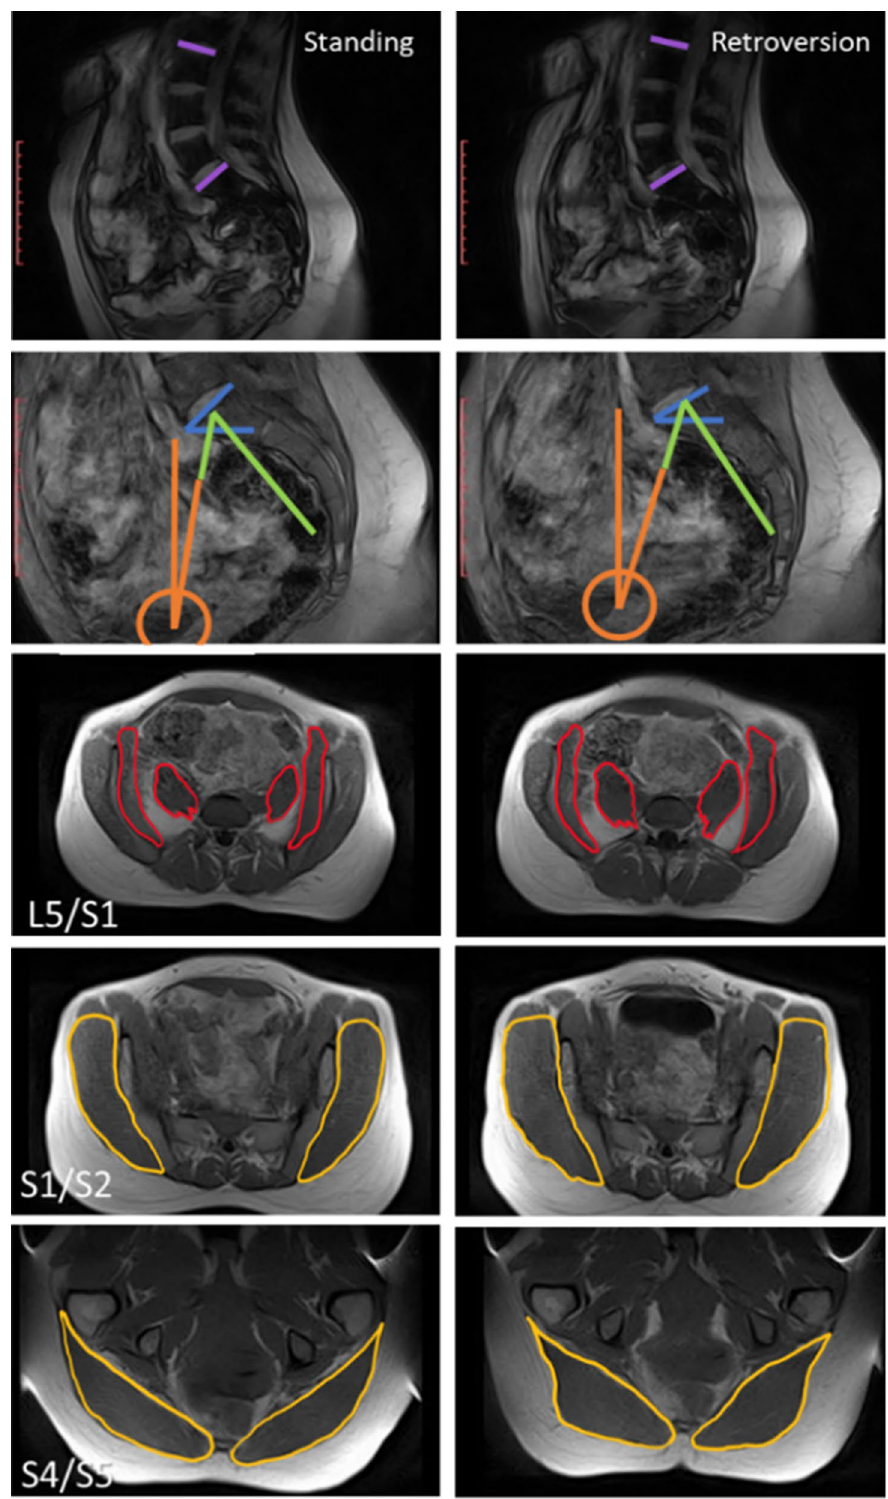
Figure 6. Sample scans illustrating correlations between muscle morphometry and geometry in standing versus retroversion. Standing scans are shown on the left column, and retroversion scans are shown in the right column. Generally, muscle CSA and circularity had significant correlations with PT (positive), SS (negative) and L3–S1 LL (negative) at specific levels. (L3–S1 LL purple, PT orange, PI green, SS blue, iliacus and psoas major red, gluteus